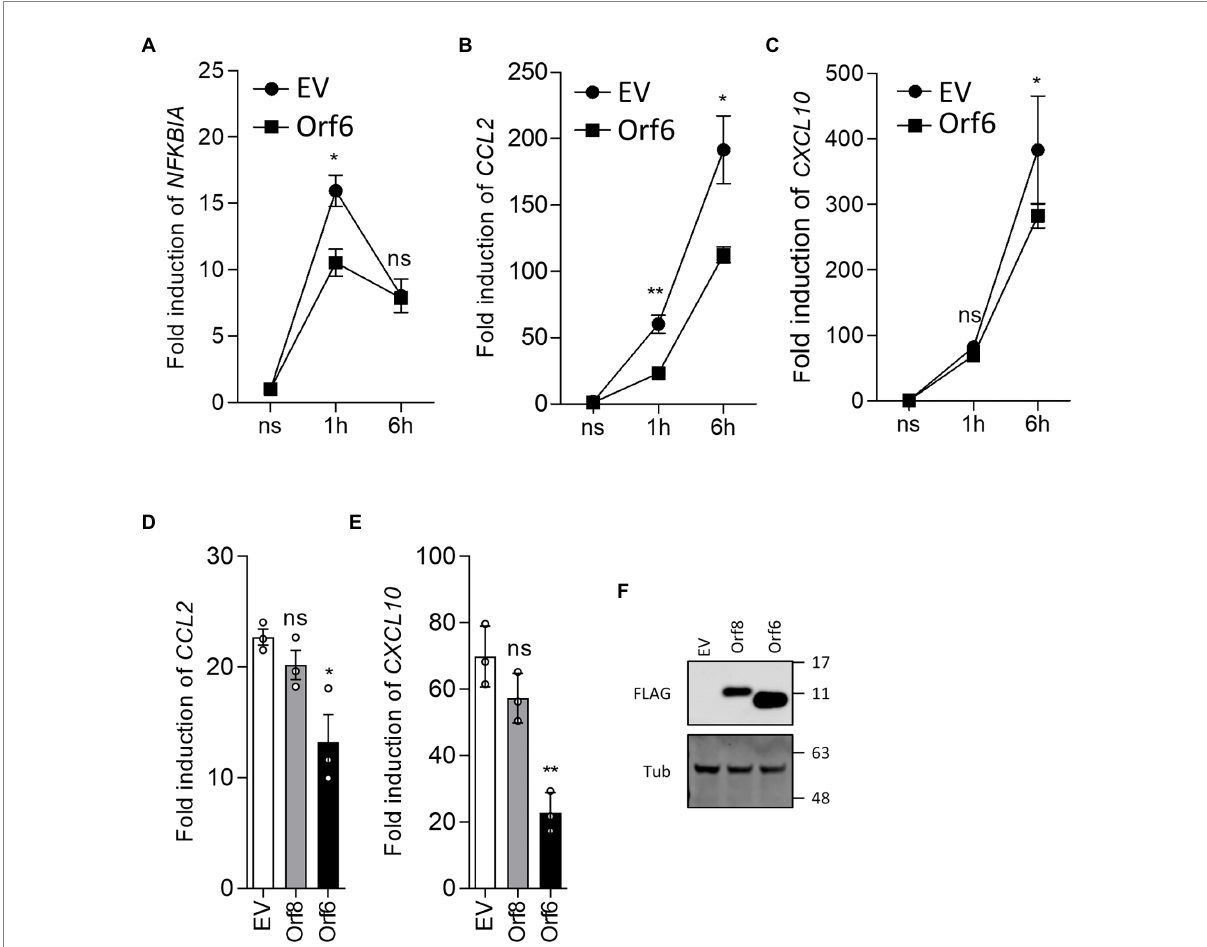
FIGURE 6 SARS-CoV-2 Orf6 suppresses the expression of NF- κ B responsive genes. (A-C) HEK293 T cells (8 × 10 5 cells per well) were transfected in triplicate with an empty vector (EV) or a plasmid expressing FLAG-tagged ORF6. After 24 h, the cells were starved in medium without serum for 3 h and then were stimulated with TNF- α (20 ng/ml). Stimulated cells were collected at 1 h and 6 h post stimulation and total RNA was extracted. The levels of mRNA for the NF- κ B responsive genes NFKBIA, CCL2 and CXCL10 were analyzed by RT-qPCR. Figures shown are representative data from two independent experiments. (D,E) HEK293 T cells were transfected with plasmids expressing FLAG-tagged Orf8 or Orf6 and stimulated as in (A-C) . Stimulated cells were collected at 6 h post stimulation and the levels of CCL2 and CXCL10 mRNA were analyzed by RT-qPCR. Error bars show standard deviation. The p-values were relative to empty vector in (A-C) , or to Orf8 in (D,E) (** p < 0.01 and * p < 0.05). (F) Immunoblot showing the levels of FLAG-tagged Orf6 and Orf8 in the transfected HEK293 T cells. For immunoblots, the positions of molecular mass markers in kDa are indicated on the